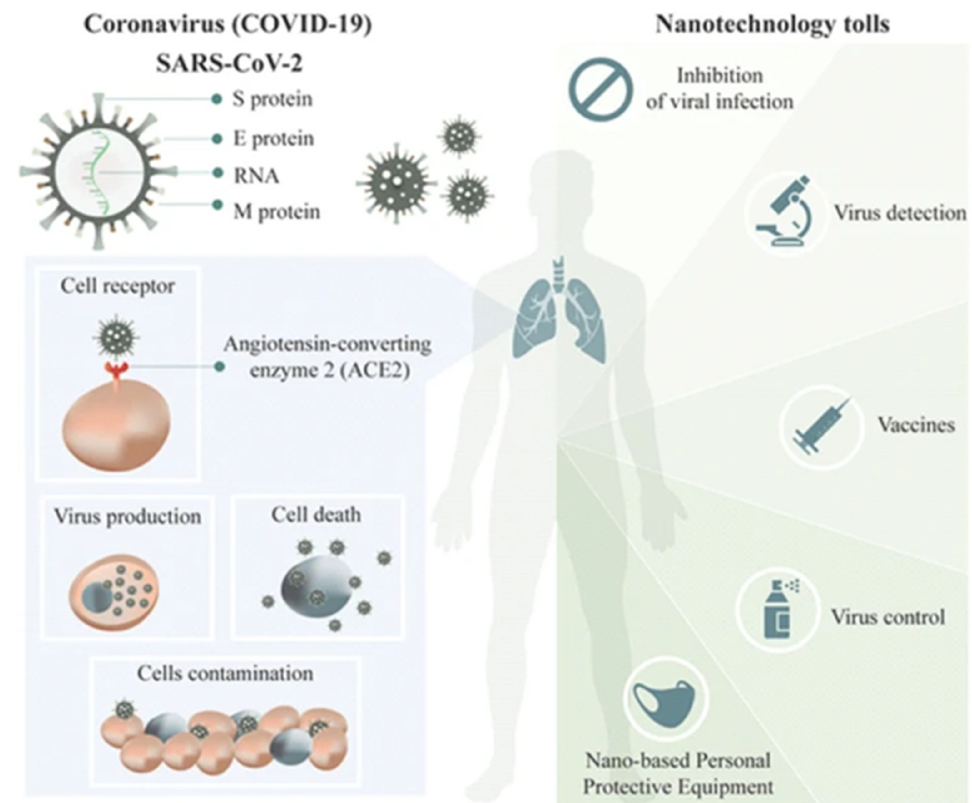
Figure 7. Nanotechnology in the prevention and treatment of COVID-19. Reprinted with permission from Springer Nature [121]. 2022, Karthik V Shankar.